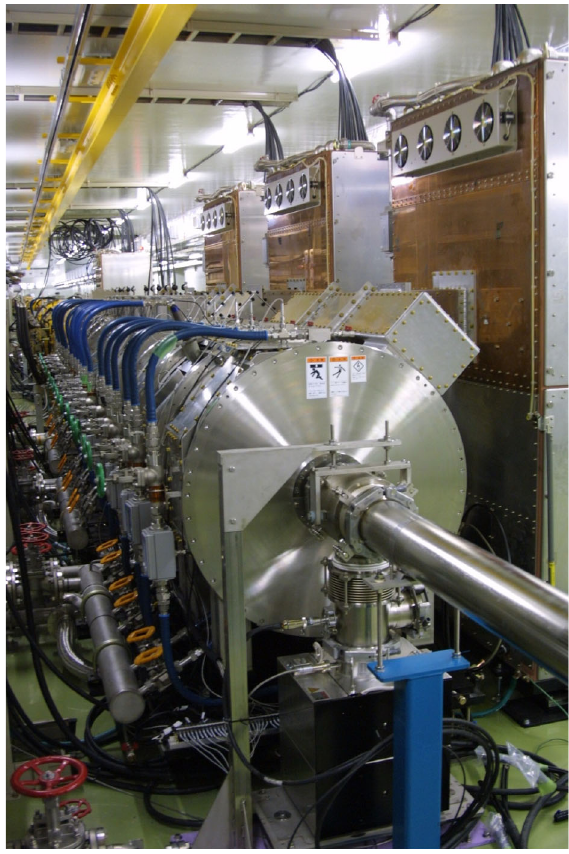
FIG. 8. The FT3L cores are installed in one cell of a 3-cell cavity in the J-PARC MR.